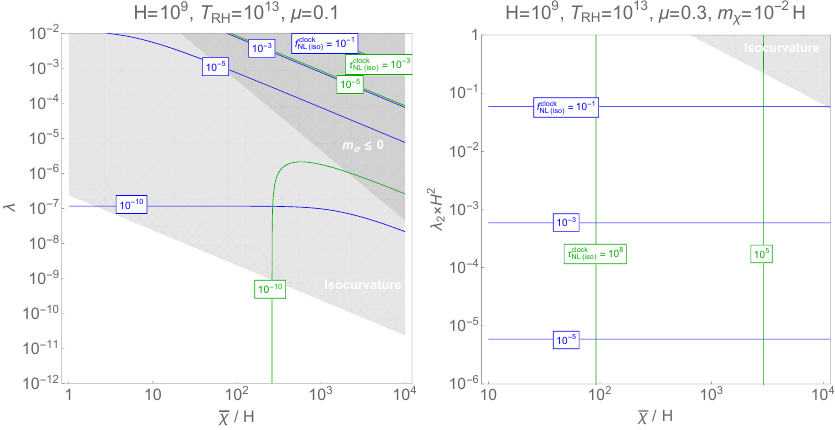
Figure 5 . The parameter scan for the modulator case, H and T RH in the unit of GeV. Blue(green) contours still stand for the size of isocurvature bispectrum(trispectrum) clock signals. The light gray shaded region is prohibited by the isocurvature perturbation observation bound. The dark gray shaded region is where m (cid:27) turns negative with given parameter. In both cases all allowed (blank) region provides enough (cid:27) DM ( f (cid:27) =1) with a proper choice of parameter A between 10 3 and 10 7